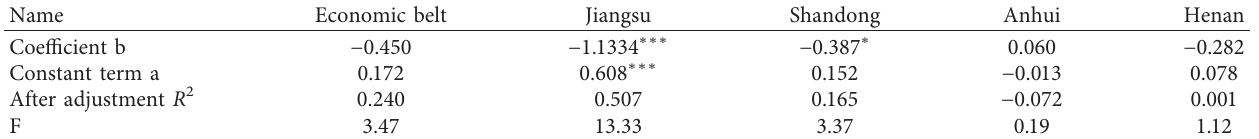
Table 6: β -convergence test of urban competitiveness in Huaihe eco-economic